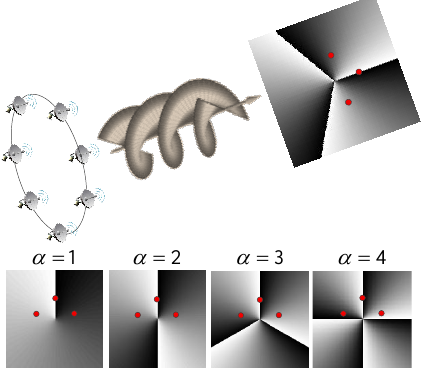
Figure 1. Illustrations of azimuth resolution using vertical radio waves with different orbital angular momentum (OAM) mode numbers. The red points stand for three scatterers with different azimuth